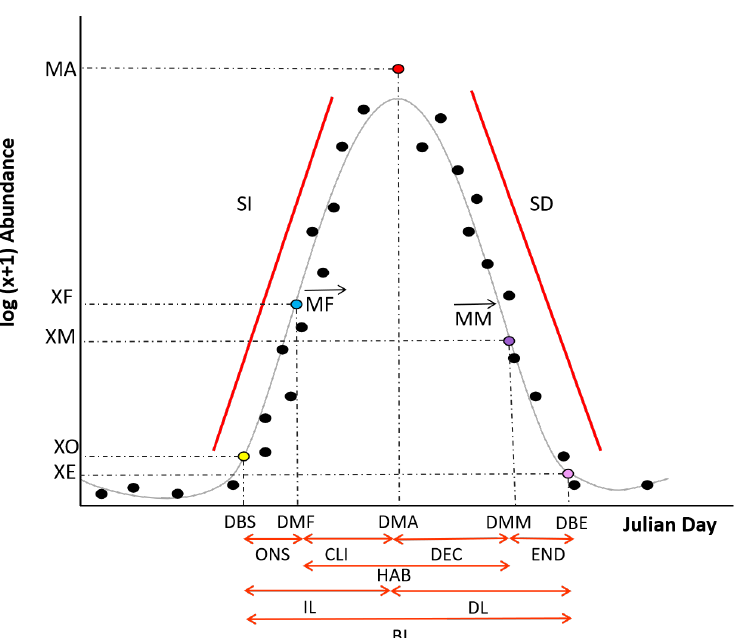
Figure 2. Summary of the 22 phenological variables extracted from each bloom detected in the time-series. DBS, Date of Bloom Start; XO, abundance at DBS; DMF, Date of Maximum Fitness; XF, Abundance at DMF; MF, Maximum Fitness, SI, Steepness Increase; MA, Maximum Abundance; DMA, Date of the Maximum Abundance; DMM, Date of Maximum Mortatlity; XM, Abundance at DMM; MM, Maximum Mortality; DBE, Date of the Bloom End; XE, Abundance at the DBE; SD, Steepness Decrease; ONS, ONSet phase duration; CLI, CLImax phase duration; DEC, DECline phase duration; END, ENDing phase duration; HAB, HArmful period; IL, Increasing Length; DL, Decreasing Length; BL, Bloom